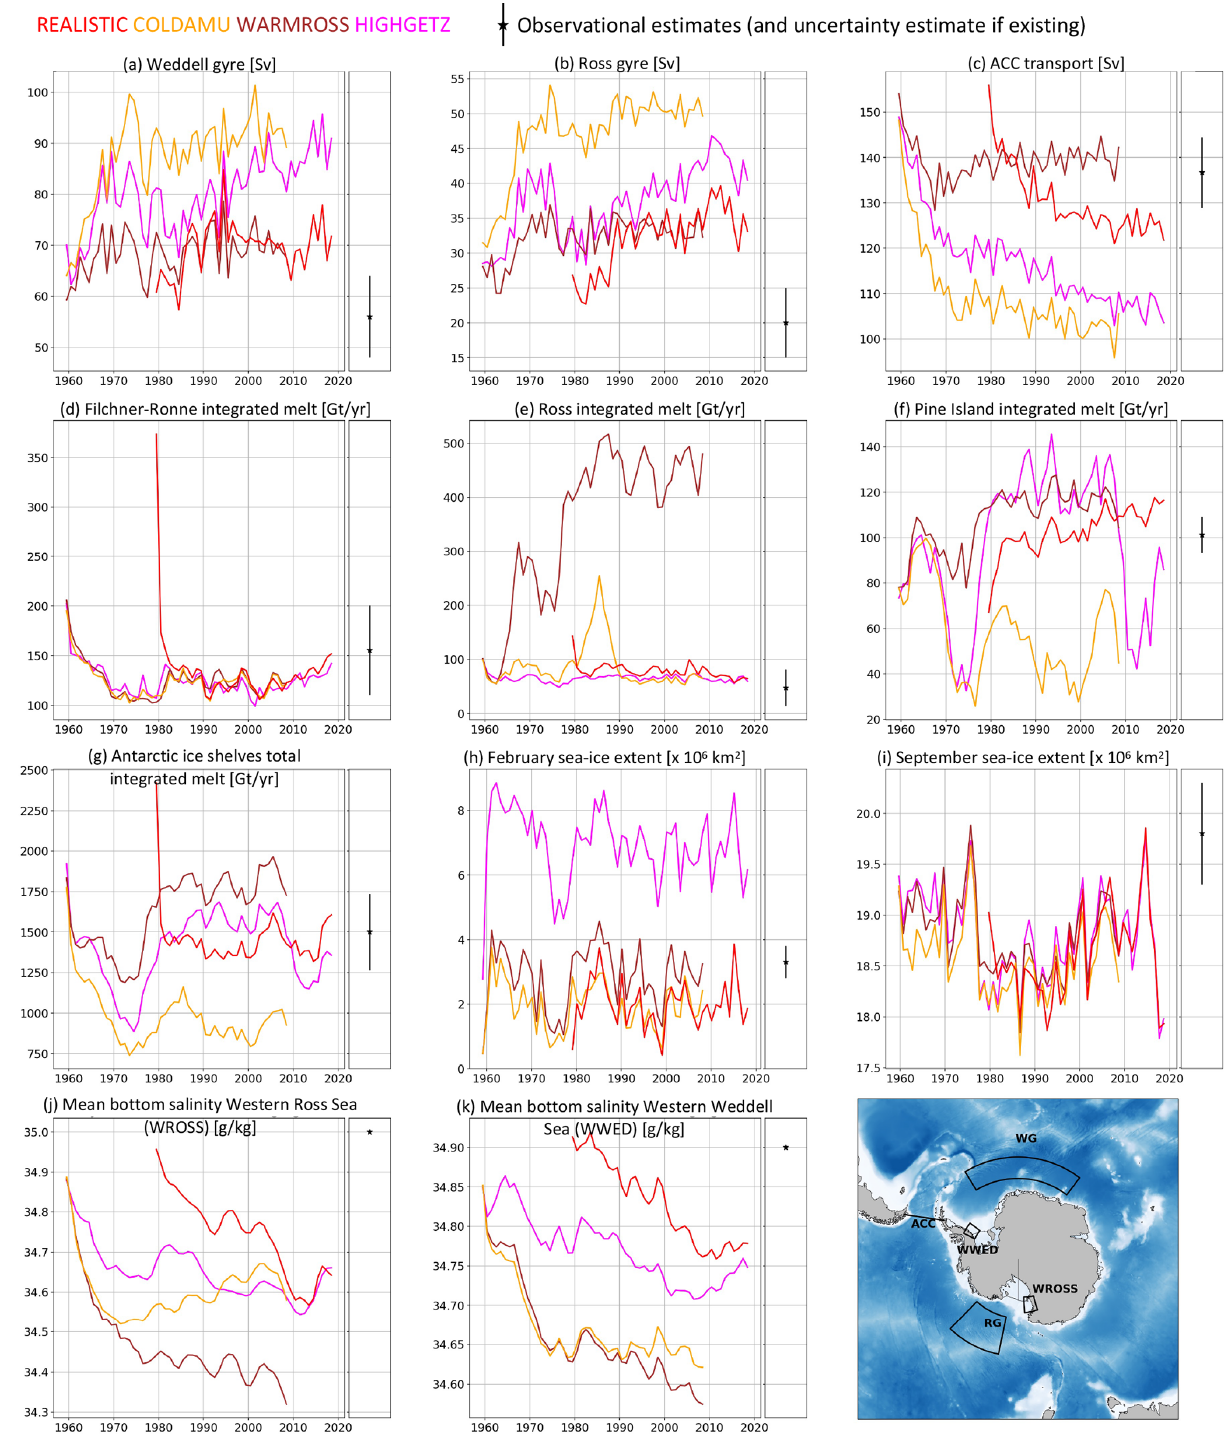
Figure B1. Time evolution of Weddell Gyre (WG) strength (a) ; Ross Gyre (RG) strength (b) ; ACC transport through Drake Passage (c) ; Filchner–Ronne, Ross, Pine Island, and Antarctica total integrated basal melt (respectively d , e , f , and g ); Antarctic sea-ice extent in February (h) and September (i) ; and mean bottom salinity in regions of deep water formation WROSS (j) and WWED (k) shown on the map. The observation estimates respectively from Klatt et al. (2005), Mazloff et al. (2010), Cunningham et al. (2003), Rignot et al. (2013) (d, e, f, g) , and Meier et al. (2017) (h, i) and WOA2018 (1981–2010) by Zweng et al. (2018) (j, k) are shown in black. Panel (l) is a map showing the boxes used to compute the mean bottom salinity (j, k) , gyre strength (a, b) , and the Drake Passage section used in panel (c) .